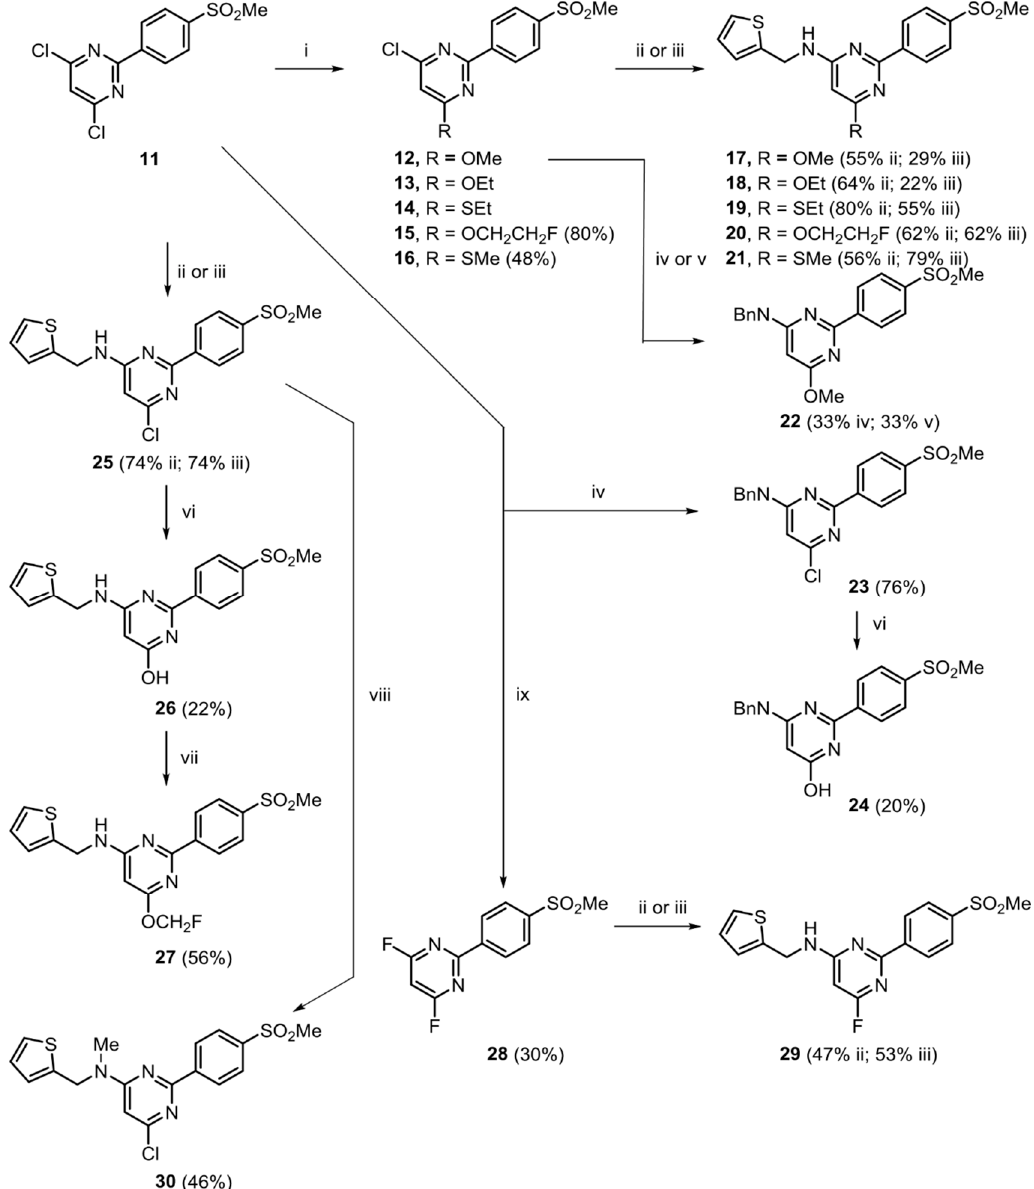
Scheme 1. Syntheses of known and potential inhibitors, and precursors for radiolabeling. Reagents and conditions: (i) for 12 , 13 , and 15 , RX, NaH, THF, RT, 3 h; for 14 (R = SEt) and 16 (R = SMe): RNa,